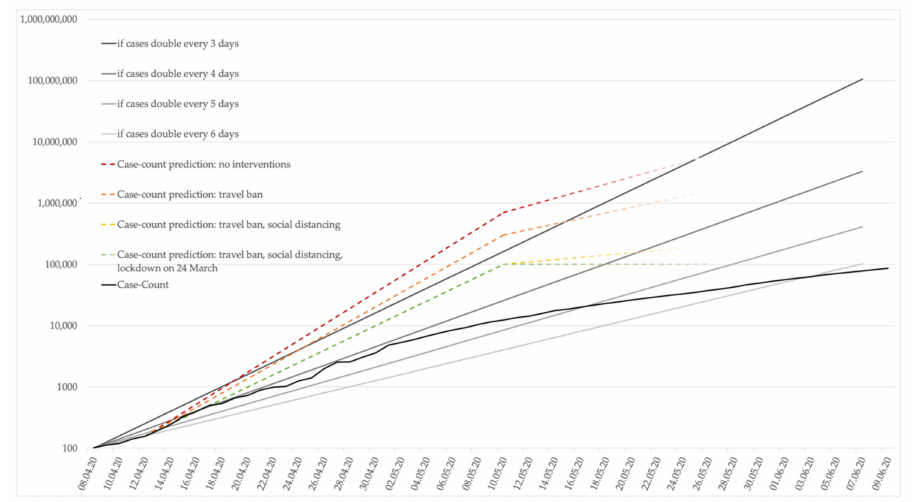
Figure 2. Logarithmic display of COVID-19 case-count and prediction, according to Ray et al. [31] (until 15 May) in relation to doubling time from the 100th case